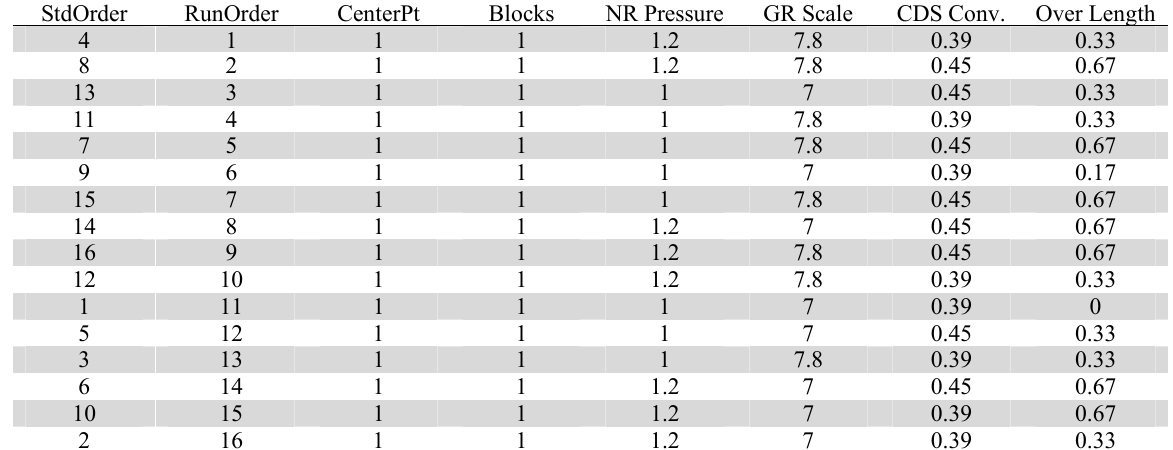
Design of experiment crimper area